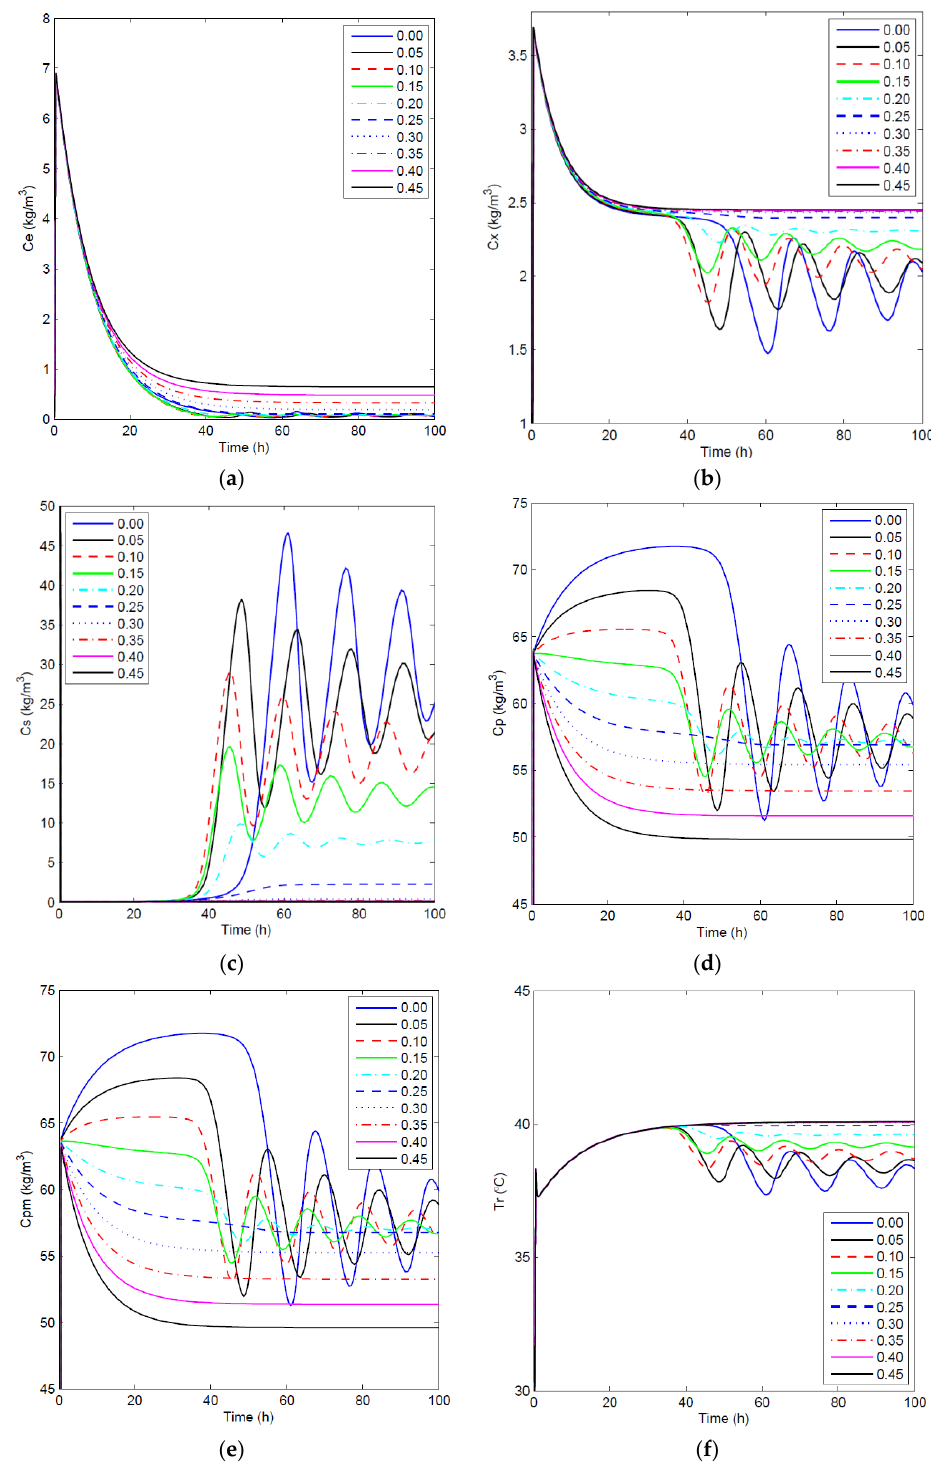
Figure 5. Open-loop simulations: concentration profiles of key component ( a ), biomass ( b ), substrate ( c ) and product in the fermentor ( d ), the membrane side ( e ) and the temperature profile ( f ) for different values. D m , in